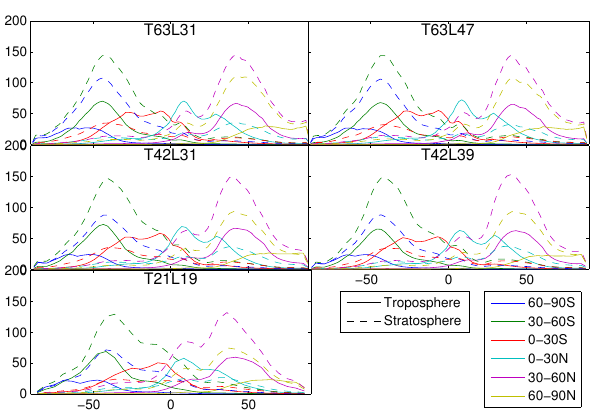
Fig. 11. Zonal mean deposition flux of 10 Be atoms (m − 2 s − 1 ) with different resolutions. Fluxes of 10 Be produced in different at- mospheric compartments are shown separately (30-degree latitude bands in the stratosphere and the troposphere).